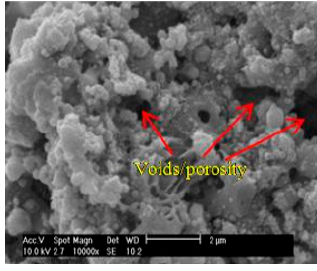
Figure 7. Possible route of particle formation in the SPPS process. Reproduced with permission from [39], Elsevier, 2017.